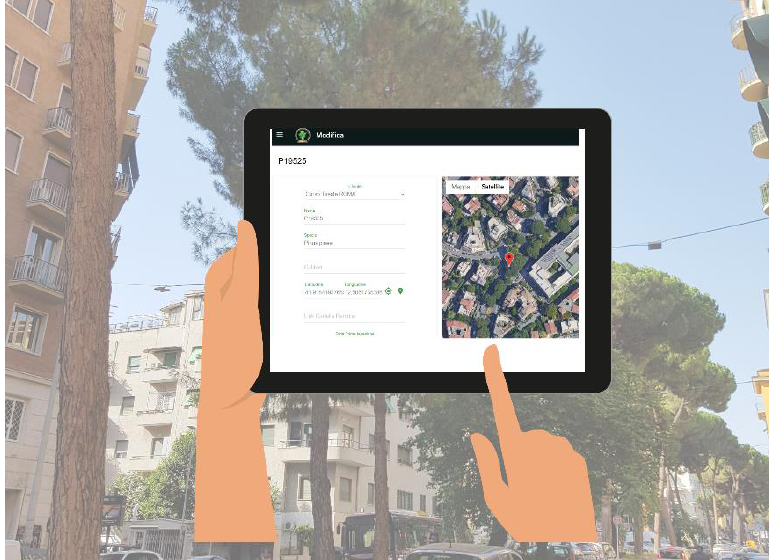
Figure 6. SYSTUS interface (www.systus.it, accessed on 31 March 2021) used to geo-reference Pinus pinea L. along Corso Trieste.